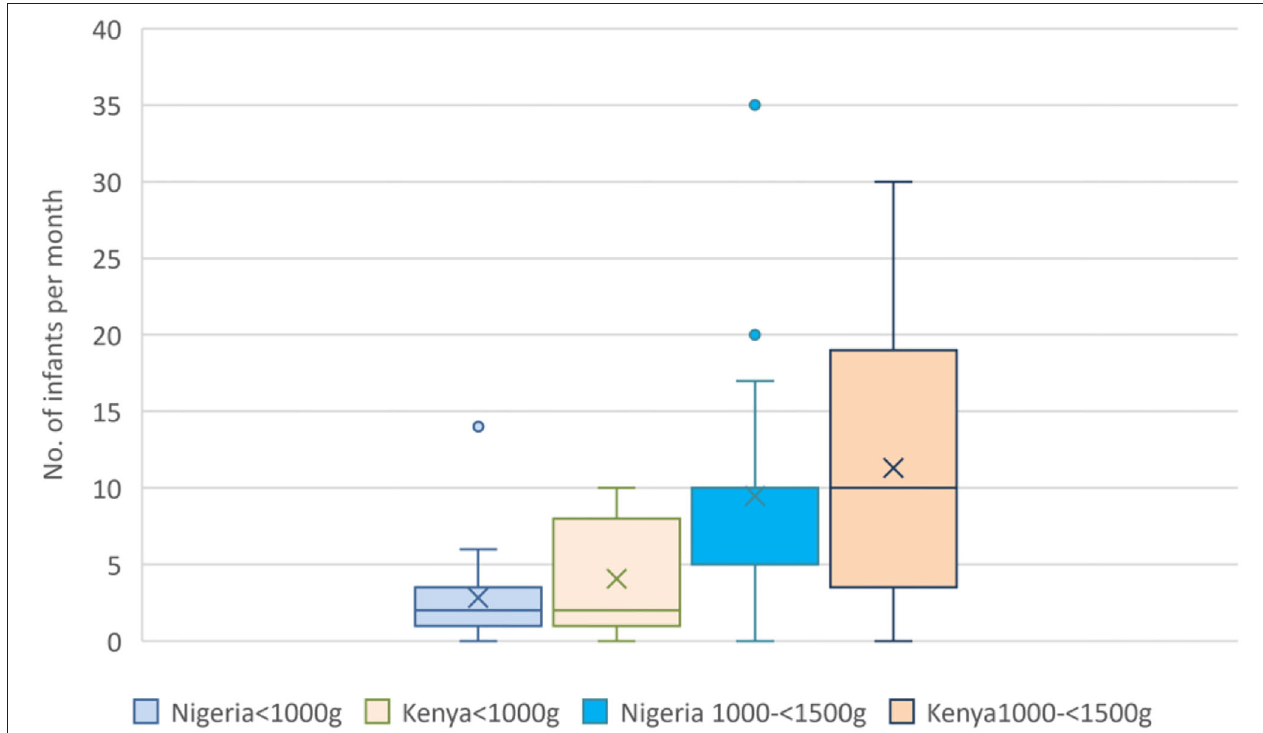
FIGURE 1 | Reported number of admissions of very low birthweight infants per month. Boxes show the IQR with solid line marking the median; X marks the mean; whiskers mark “minimum” (1st quartile-1.5 IQR) and “maximum” (3rd quartile + 1.5 IQR) values; dots show outliers.